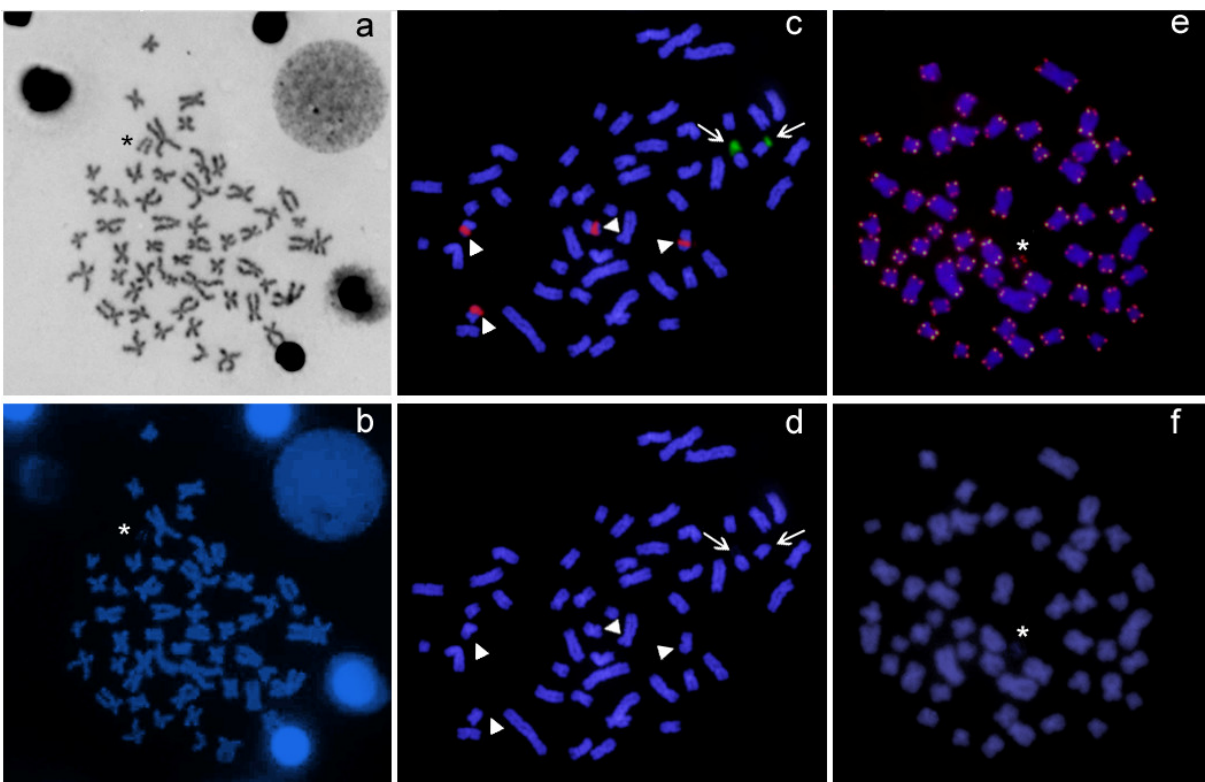
Figure 3. Mitotic chromosomes of A. clementinae . Female metaphase in sequential ( a ) Giemsa and ( b ) DAPI staining; male ( c ) after dual-color FISH experiments with ribosomal 18S (green) and 5S (red) rDNA probes and corresponding DAPI ( d ); female metaphases hybridized with the telomeric (TTAGGG) n probe ( e ) and corresponding DAPI ( f ). Asterisk indicates the W 2 chromosome; arrows indicate 18S rDNA sites and arrowheads 5S rDNA sites.